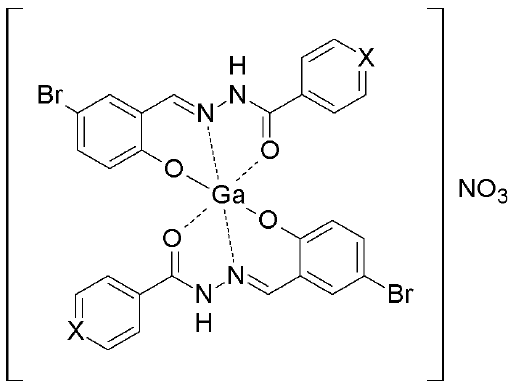
Figure 2. The suggested structure of Ga(III) Complexes 1 (X = C-OH) and 2 (X = N).